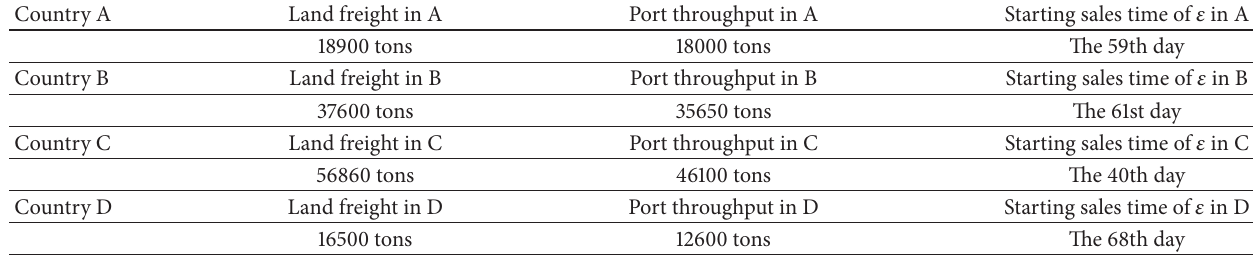
Table 7: Simulation results of freight volume and period in Scheme 2.